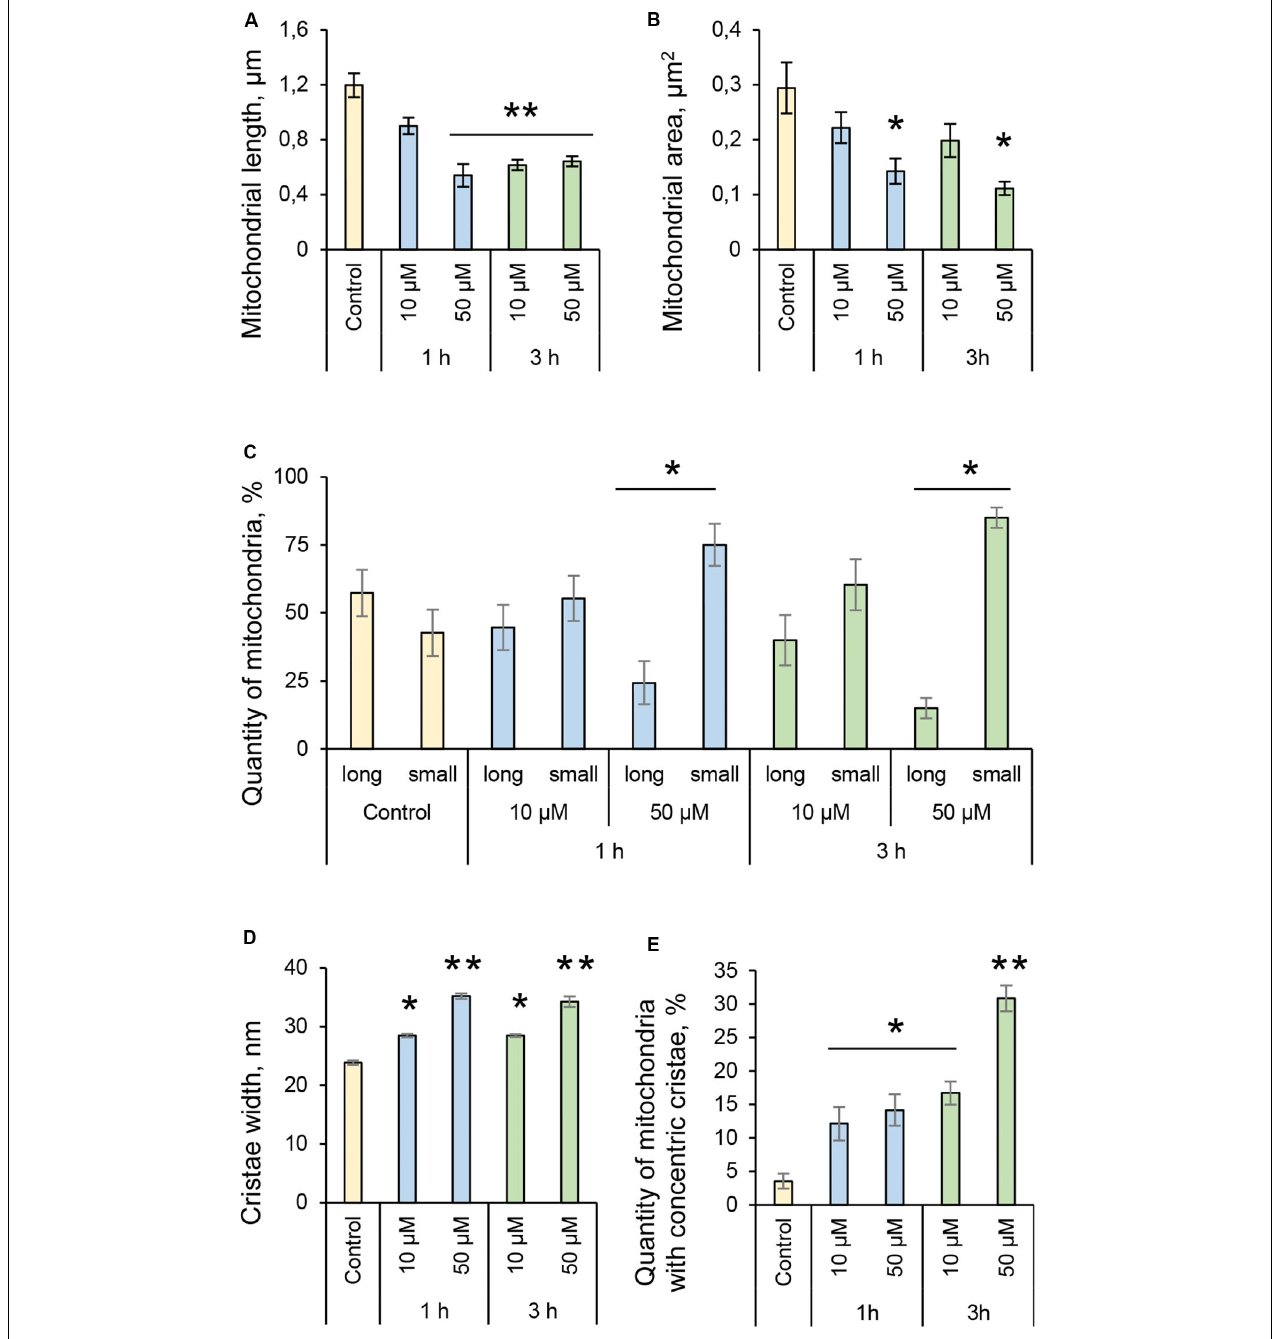
FIGURE 3 | Quantification of mitochondria dynamics and ultrastructure in fibroblasts in response to 3O-C 12 -HSL. (A) Mitochondrial length, µ m. (B) Mitochondrial area, µ m 2 . (C) Quantity of mitochondria, %. Long organelles were considered as > 0,2 µ m 2 and small as < 0,2 µ m 2 . (D) Cristae width, nm. (E) Quantity of mitochondria with concentric cristae, % of control. Columns represent the mean ± SE. Significant differences are indicated with * P < 0.05 and ** P < 0.01, as analyzed by two-tailed Student’s t -test. Data from three different experiments performed on separate days on different cell passages, and at least 300 mitochondria in different cells per condition were analyzed.